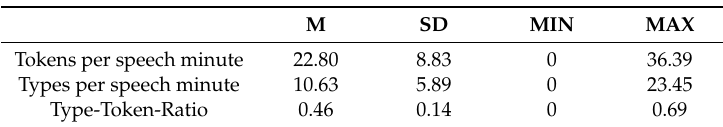
Table 2. Verbs in Input (M refers to the mean value, SD to the standard deviation, MIN and MAX to minimum and maximum respectively.